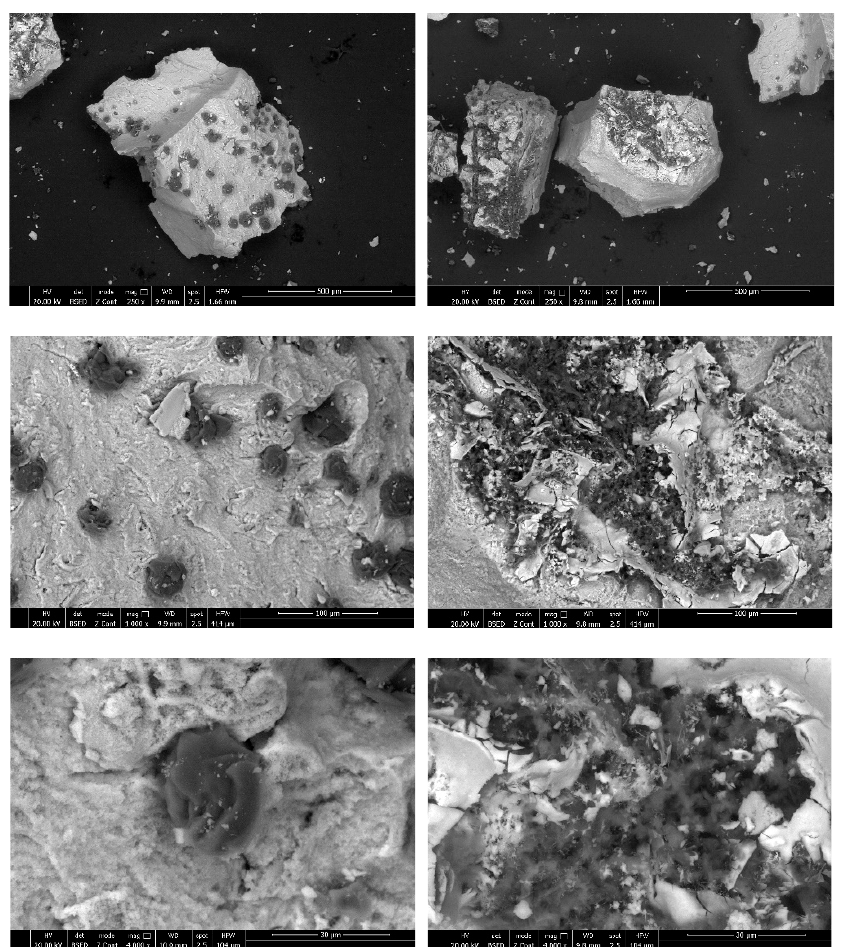
Figure 4. SEM images of the hybrid compound S1 .